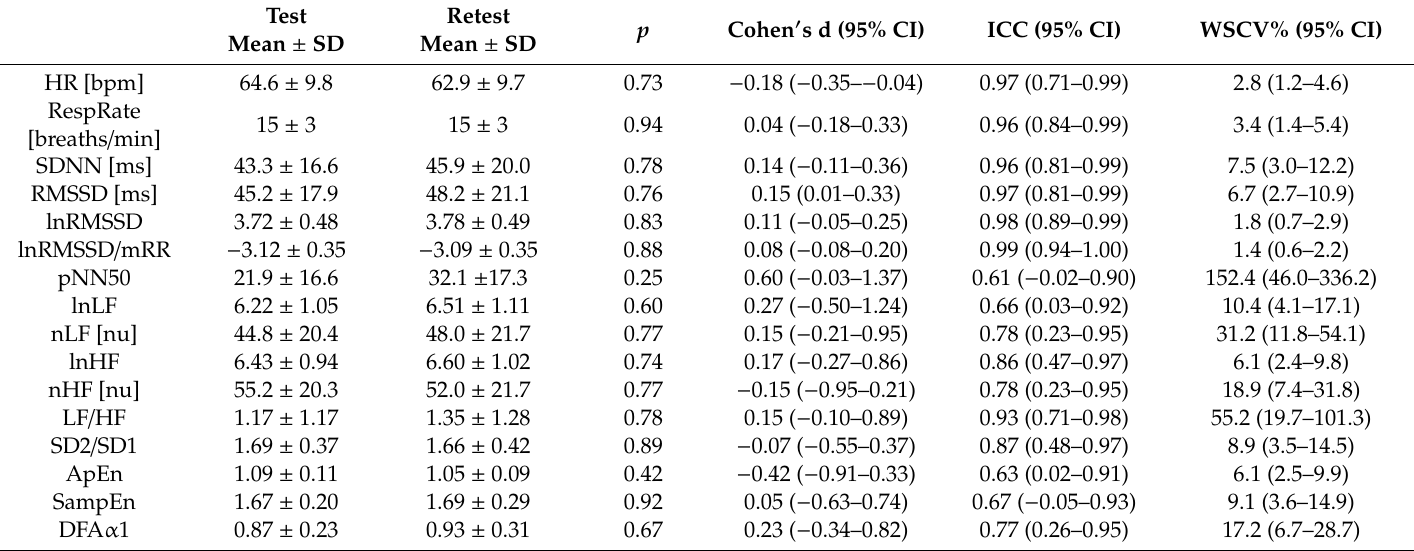
Table 1. Reliability results for HR, RespRate and selected short-term 5 min HRV